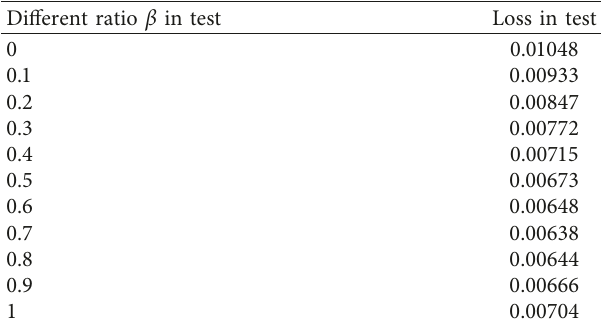
Table 7: Results of the different ratios in the test. Different ratio β in test